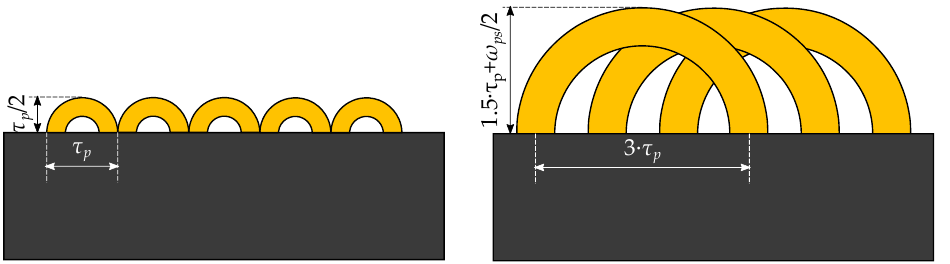
Figure 6. Modeled size for the end windings. Double-layer concentrated winding ( left ) single-layer distributed winding ( right